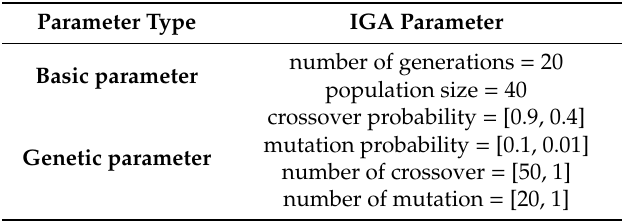
Table 4. Model parameters of the improved genetic algorithm (IGA) used for the training and testing of